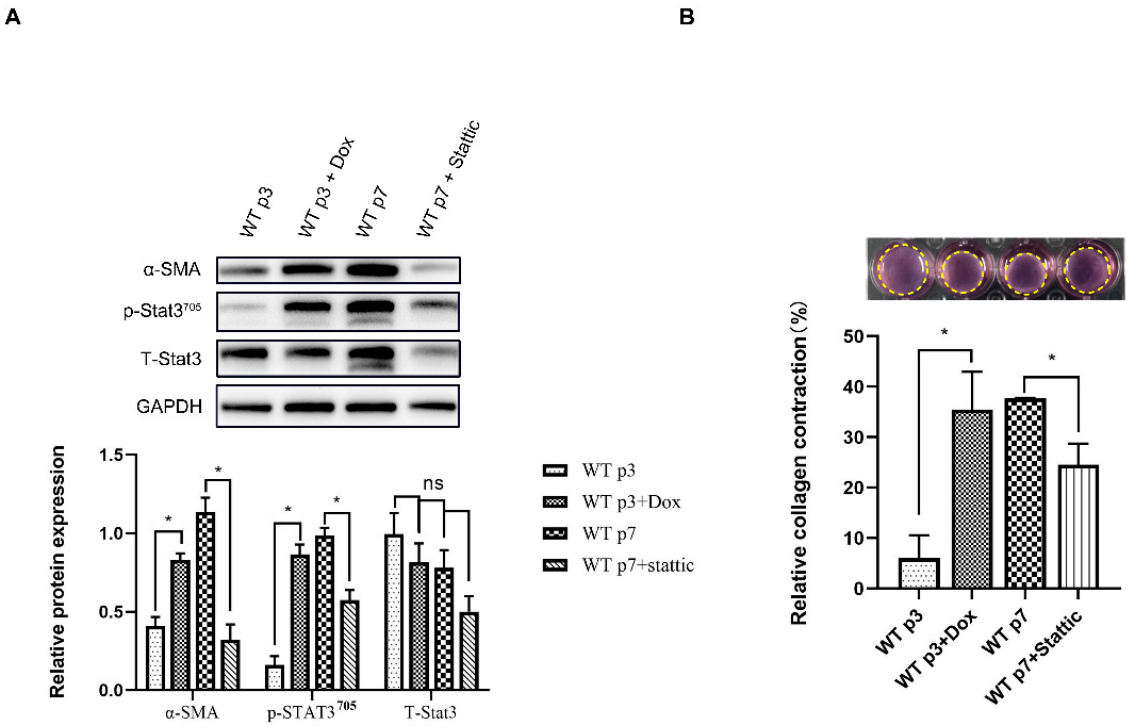
Figure 3. Senescent fibroblasts display CAF Properties through the Stat3 pathway. ( A ). Western blotting analysis for α -SMA, p-Stat3 and Stat3 of young fibroblasts (p3), young fibroblasts (treated with dox or replicative senescence) and senescent fibroblasts treated by Stattic. Quantification of the Western blotting and statistical analysis; *, p < 0.05. and ns indicate non-significance. ( B ). Fibroblasts as in A were subjected to a collagen contraction assay.